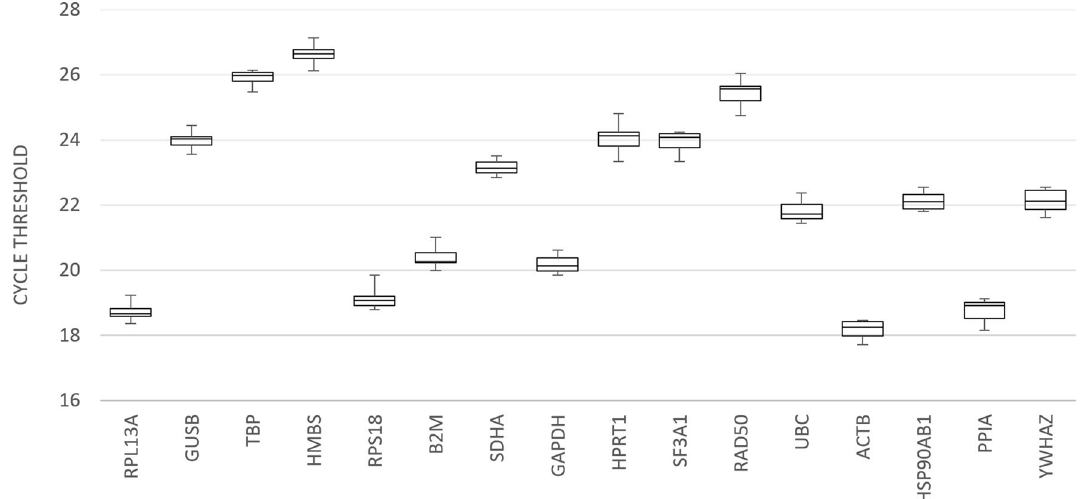
Figure 1. Range of fluctuation of candidate RG Ct values. Box-and-whiskers plot illustrating range of fluctuation of candidate RG Ct values across fibroblast cell lines (n = 7) in order (from left to right) of increasing interquartile range. Each cell line was reverse transcribed in triplicate and combined, and subsequently assayed in technical triplicates. Mean of technical replicates were used in this analysis. The first quartile, median, and third quartile are indicated by the lower limit of the box, the line within the box, and the upper limit of the box, respectively. The whiskers represent the minimum and maximum values. Data represent one independent experiment.